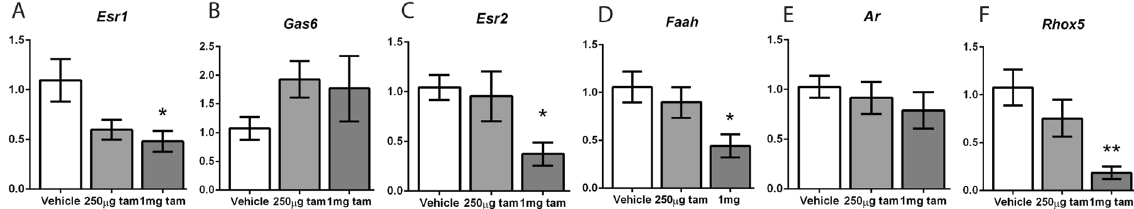
Figure 7. A single dose of 1 mg tamoxifen at d16 changes the androgen/estrogen balance in the testis. ( A ) Expression of the estrogen receptor α transcript Esr1 is significantly decreased at 7 weeks after a single 1 mg (but not 250 µ g) tamoxifen treatment at d16 in INYF mice. ( B ) Gas6 is not significantly changed after either a 1 mg or 250 µ g dose. ( C ) Esr2 expression is significantly decreased after a 1 mg tamoxifen dose but not a 250 µ g dose. ( D ) Faah expression is significantly decreased after a 1 mg tamoxifen dose but not a 250 µ g dose. ( E ) Ar expression is not significantly different in either group. ( F ) Rhox5 is significantly decreased in the 1 mg treated group but unchanged in the 250 µ g treated group (All qPCRs n ≥ 5, error bars are